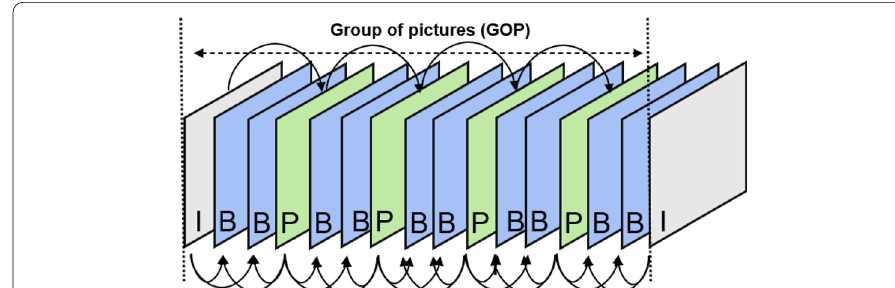
Fig. 1 The group of pictures (GOP) structure